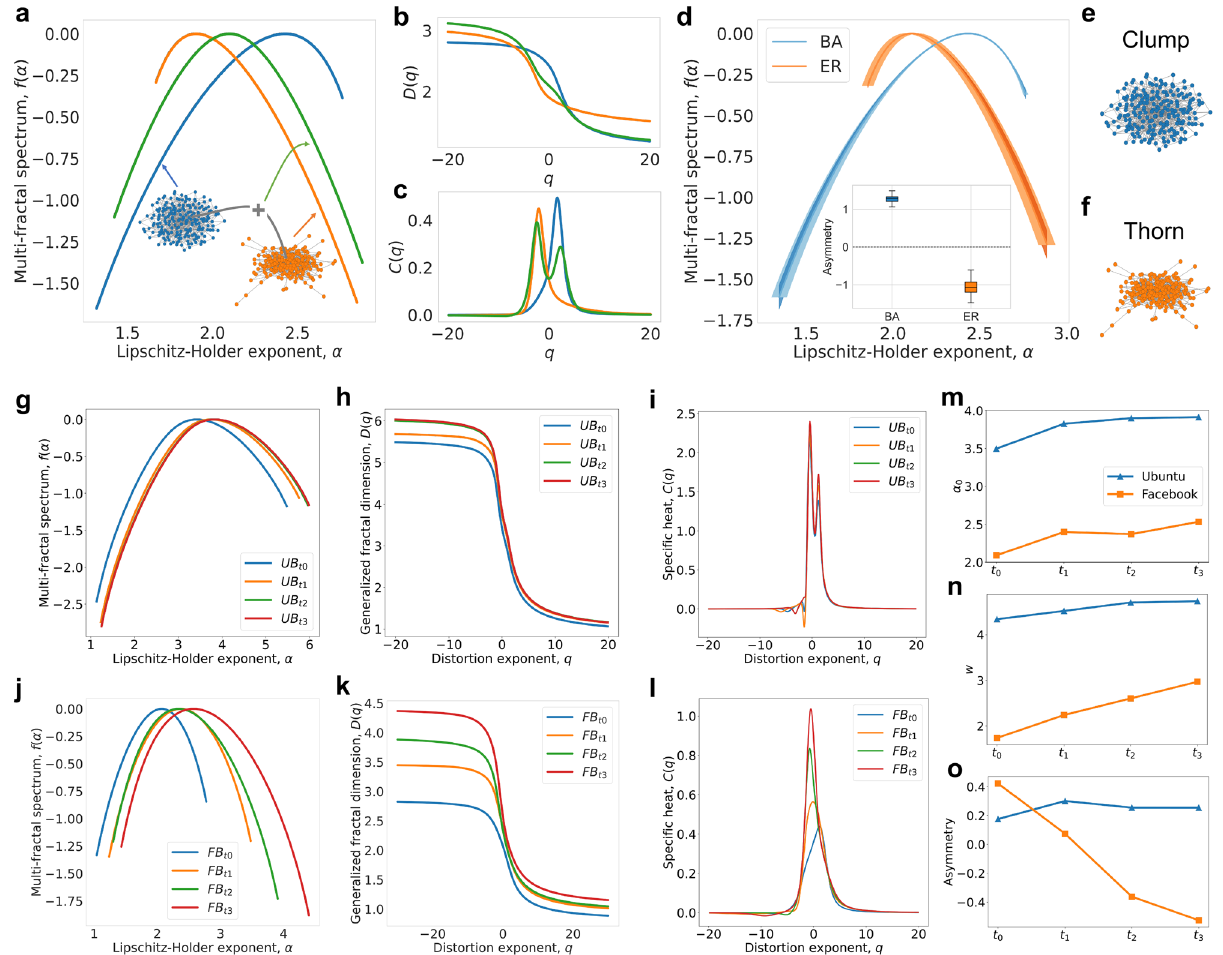
Figure 3. NMFA of real complex social networks. ( a–c ) We use BA and ER models to generate two networks with a similar number of nodes (200) and edges (600), and a merged network of them by linking their highest connected nodes with one edge ( a ). The differences between their multifractal spectra ( a ), generalized fractal dimension ( b ), and specific heat distributions ( c ). The BA, ER, and merged networks are represented as blue, orange, and green respectively. ( d ) We use the BA and ER models to generate 100 networks with a similar number of nodes (200) and edges (600) and measure their multifractal spectra and asymmetry shown in ( d ). The solid lines in the figures represent the mean value while the shades represent the 99% confidence interval. ( e,f ) The different structural features of BA network (clump) ( e ) and ER network (thorn) ( f ). ( g–l ) We use NMFA to show the multifractal features of two typical social networks changing over time. ( g–i ) The variations of the multifractal spectra ( g ), the generalized fractal dimension ( h ), and the specific heat distributions ( i ) of the Ask Ubuntu networks. ( j–l ) The variations of the multi-fractal spectra ( j ), generalized fractal dimension ( k ), and specific heat distributions ( l ) of the Facebook-like Forum networks. ( m–o ) The variation of the degree of complexity ( m ), heterogeneity ( n ), and asymmetry ( o ) of the two social networks for different time see that the network generated under a specific generating mechanism has the stable multifractal spectrum and multiscale asymmetry. The BA and ER networks have different degrees of asymmetry (i.e., the Asymmetry of BA network> 1, showing a “clump” property while the ER network shows a “thorn” property). To investigate whether real social networks obey a preferential attachment mechanism and show similar asym- metry as the BA model, we analyze two typical social networks (i.e., the Ask Ubuntu 32 (UB) and Facebook-like Forum 33 (FB) networks) and quantify their multifractal structures. The UB network is a typical social network, showing how people interact on an ask and answer forum; the number of users in this network has grown from 80,854 in 2013 to 157,220 in 2016. The FB network can be seen as a typical public social community covering a time span from May 2004 to October 2004, with the number of people increasing from 159 to 899. The basic information of the networks is provided in Table 1. As shown in Figures 3g–i, although more users join the UB network and more connections are established with the network size doubled from t0 (year 2013) to t3 (year 2016), the multifractal spectrum, the generalized fractal dimension and the specific heat distribution exhibit small variation from t0 (year 2013) to t1 (year 2014), and almost no change from t1 (year 2014) to t3 (year 2016). This indicates that the UB network has a robust structure in which the mechanism for newly joining users to establish connections is stable. Furthermore, this indicates that the complex network can be simulated and described by